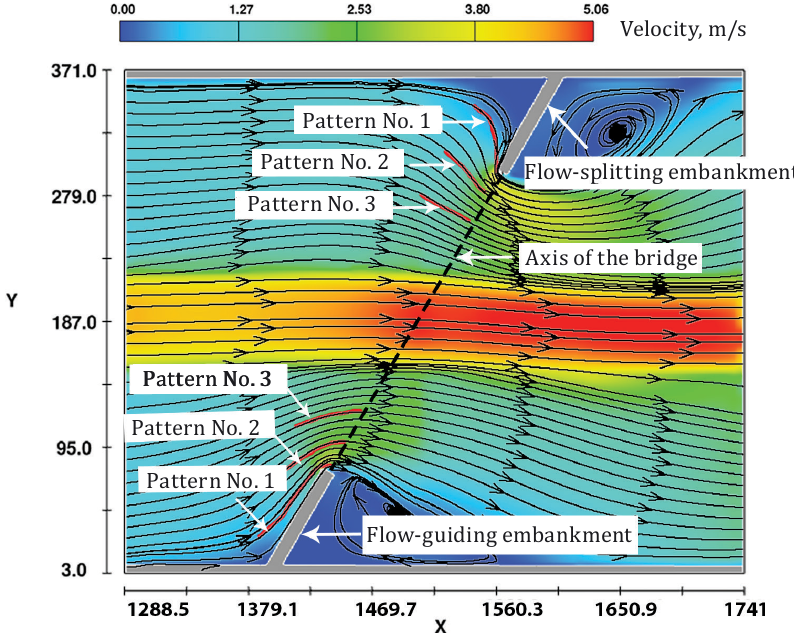
Figure 17. View of the plan for velocity distribution and streamlines formed around a vertical-wall at a skew of